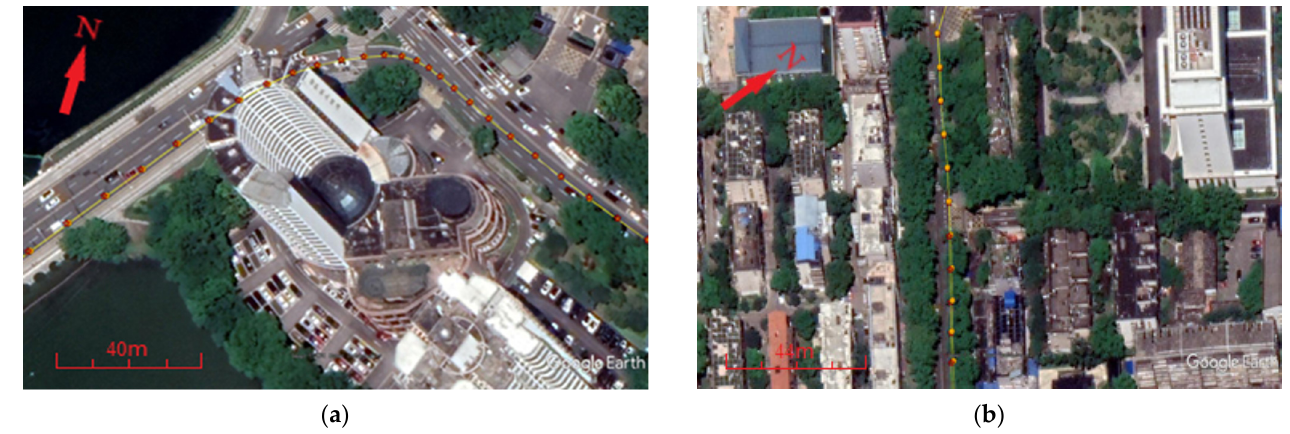
Figure 12. The positioning result for UD-KF ( a ) and DD-KF ( b ) for different scenes.